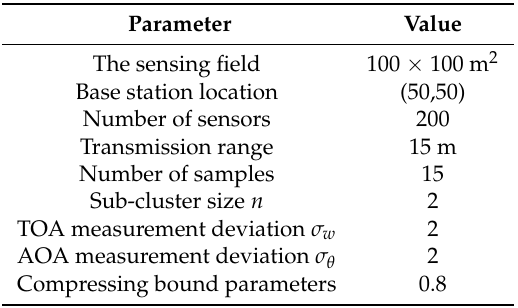
Table 2. The values of the simulation parameters.